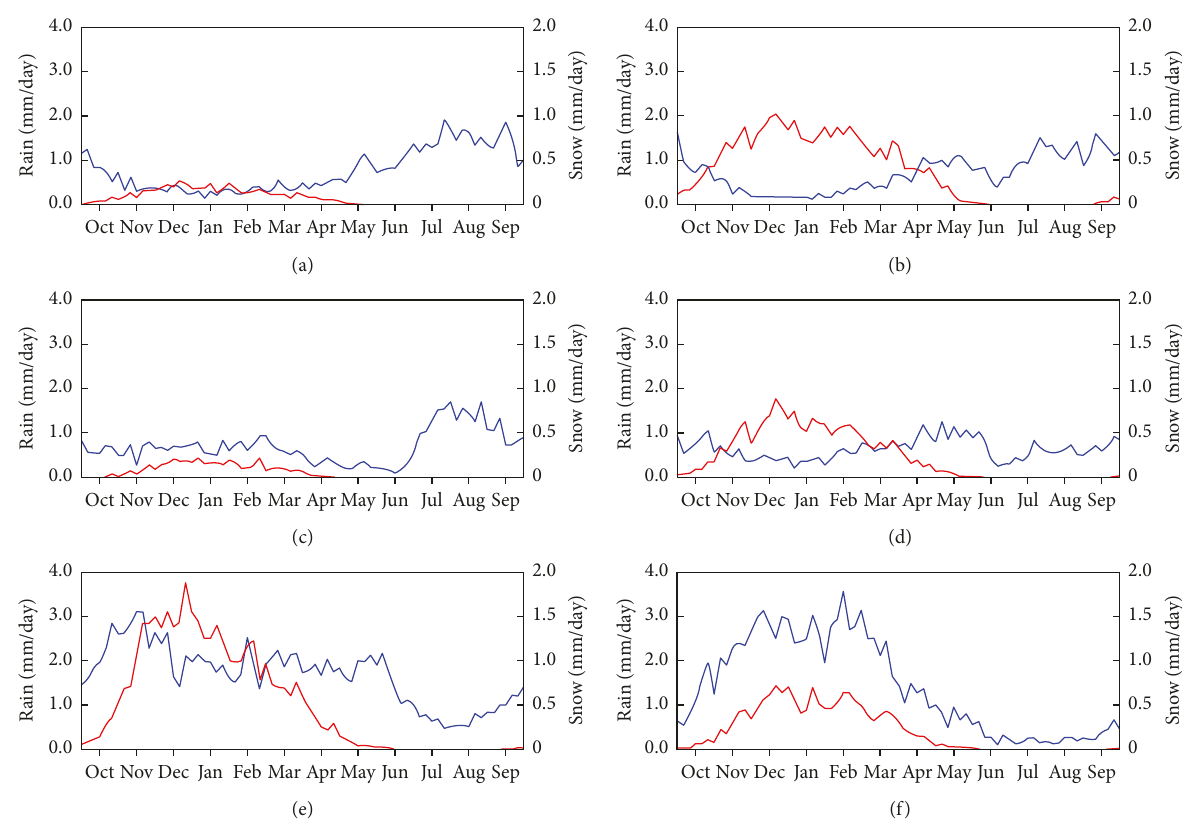
Figure 4: Annual time series (1981–2016) of the regional mean precipitation (blue line: rain; red line: snow). Panels (a)–(f) successively represent watersheds (a) RG, (b) UC, (c) LC, (d) GB, (e) PNW, and (f)